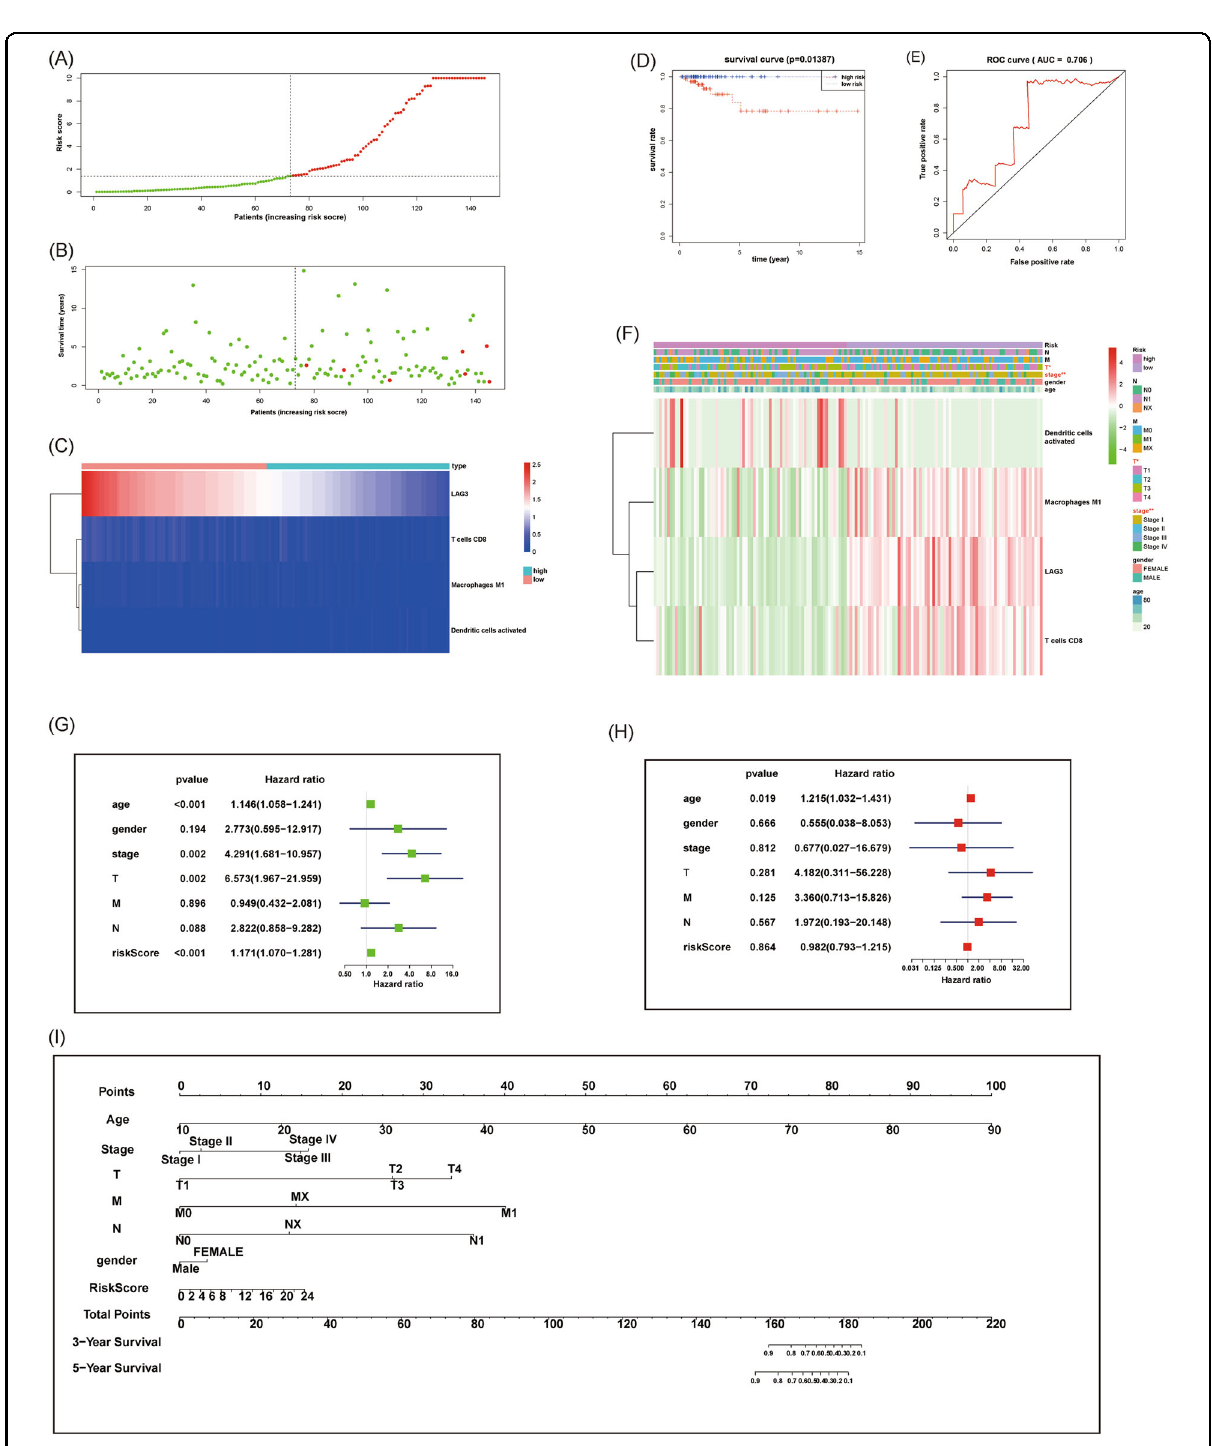
Fig. 7 Establishment of an immune risk score for prediction of prognosis. A Distribution of immune risk scores in PTC patients. B Distribution of survival status in PTC patients. C Distribution of speci fi c risk factors (LAG3, CD8 + T cells, M1 macrophages, and activated DCs) in the high- and low-risk groups (divided by median value). D Kaplan – Meier survival curves of overall survival between the high- and low-risk groups. E ROC curve AUC statistics for assessing the predictive capability of the immune risk score model. F Correlation between immune risk score and clinical characteristics. G Univariate Cox regression analysis for seven clinicopathological parameters affecting overall survival. H Multivariate Cox regression analysis for seven clinicopathological parameters affecting overall survival. I Established a nomogram to visualize the immune risk score model. (* P < 0.05, ** P <